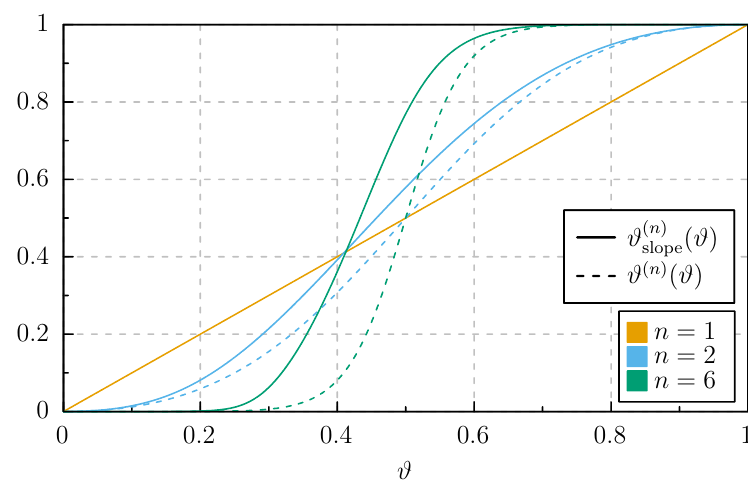
Figure 5: Comparison between the two effective n -dependent filling fractions (93) and (94), for a few different choices of n . In the case of von Neumann entropy (i.e. for n = 1), the effective filling fraction is just ϑ , while for n (cid:54) = 1 we get two ( n ) coming from the renormalised quasiparticle velocity and different predictions: ϑ slope ϑ ( n ) extracted from the stationary state. The two quantities agree for small ϑ or 1 − ϑ , while for the intermediate ϑ , the difference between the two increases with | n − 1 |